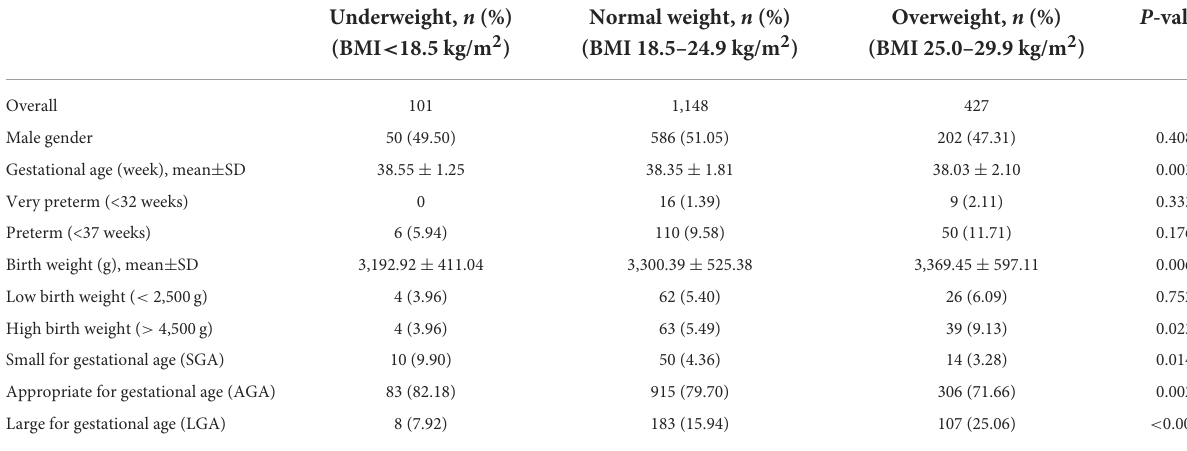
TABLE 2 Neonatal outcomes according to pre-pregnancy BMI among women with PCOS following frozen-thawed embryo transfers. Underweight, n (%) Normal weight, n (%) (BMI < 18.5 kg/m 2 ) (BMI 18.5–24.9 kg/m 2 )